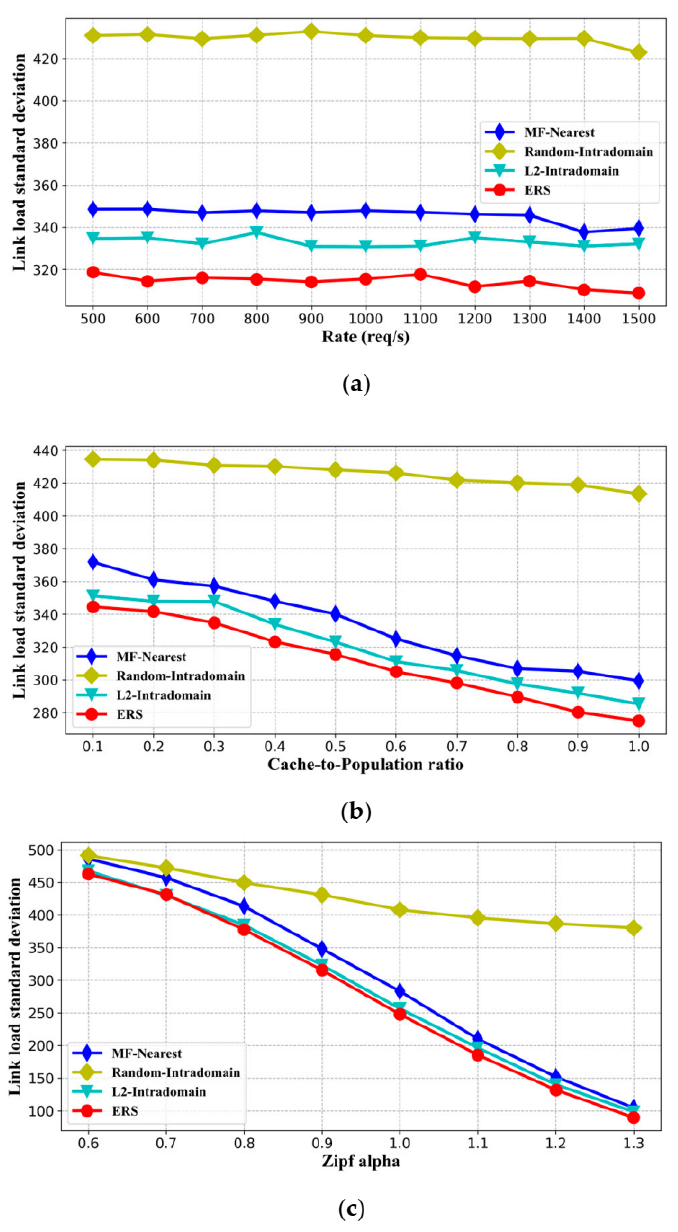
Figure 8. The standard deviation of link load comparison with different impact factors. ( a ) Request rate, ( b ) cache-to-population ratio, and ( c ) Zipf parameter